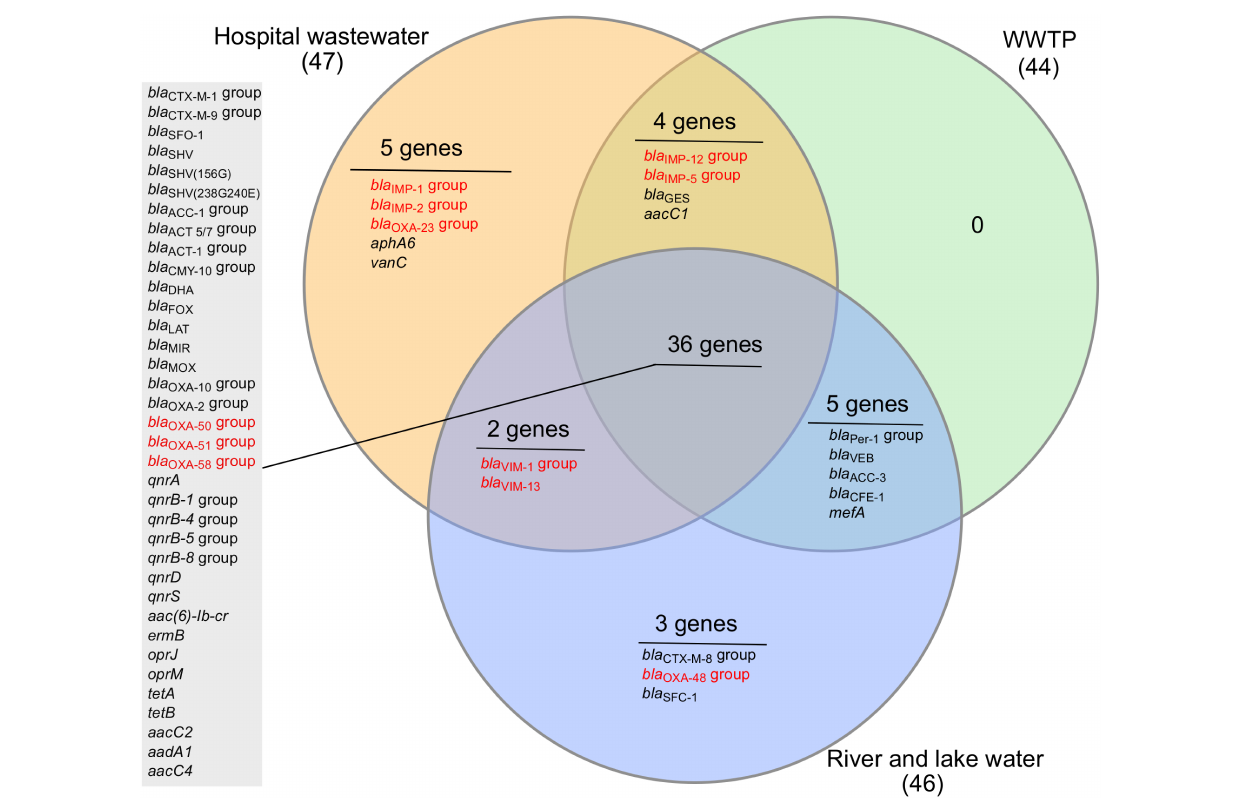
FIGURE 4 | Venn diagram of antibiotic-resistance genes detected in the hospital wastewater, wastewater treatment plant (WWTP), and recipient river and lake waters. The number in the bracket indicates the total number of genes detected from a particular sample type. The results from all six samples were divided into three sets based on the sample type; hospital wastewater, wastewater from WWTP (combined incoming and effluent wastewater), and aquatic environments (upstream river and downstream river and lake water). The genes detected in all sample types are listed in the gray-shaded box. Carbapenemase genes are highlighted in red